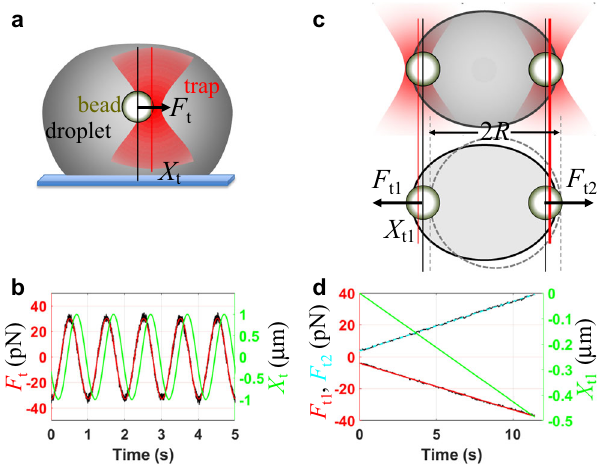
Fig. 2 Design of experiments for measuring viscous and elastic moduli and interfacial tension. a Oscillatory micro-rheology inside a settled droplet. b Time traces of the trap position ( X t ; green) and trapping force ( F t ; black) on a bead inside a pK:H droplet. A fi t of the force trace to a cosine function of time is shown in red. The oscillation frequency ( ω /2 π ) was 1 Hz. c A droplet suspended by two trapped beads at the opposite poles (top: side view; bottom, top view). Trap 2 was fi xed in place while trap 1 was pulled toward the left. d Traces of the trap 1 position ( X t1 ; green) and traps 1 and 2 forces ( F t1 and F t2 ; black) measured on a pK:H droplet. The force traces were smoothed by moving average over a 64-ms window; linear fi ts are overlaid. Trap 1 was pulled at a constant speed of ~0.05 μ